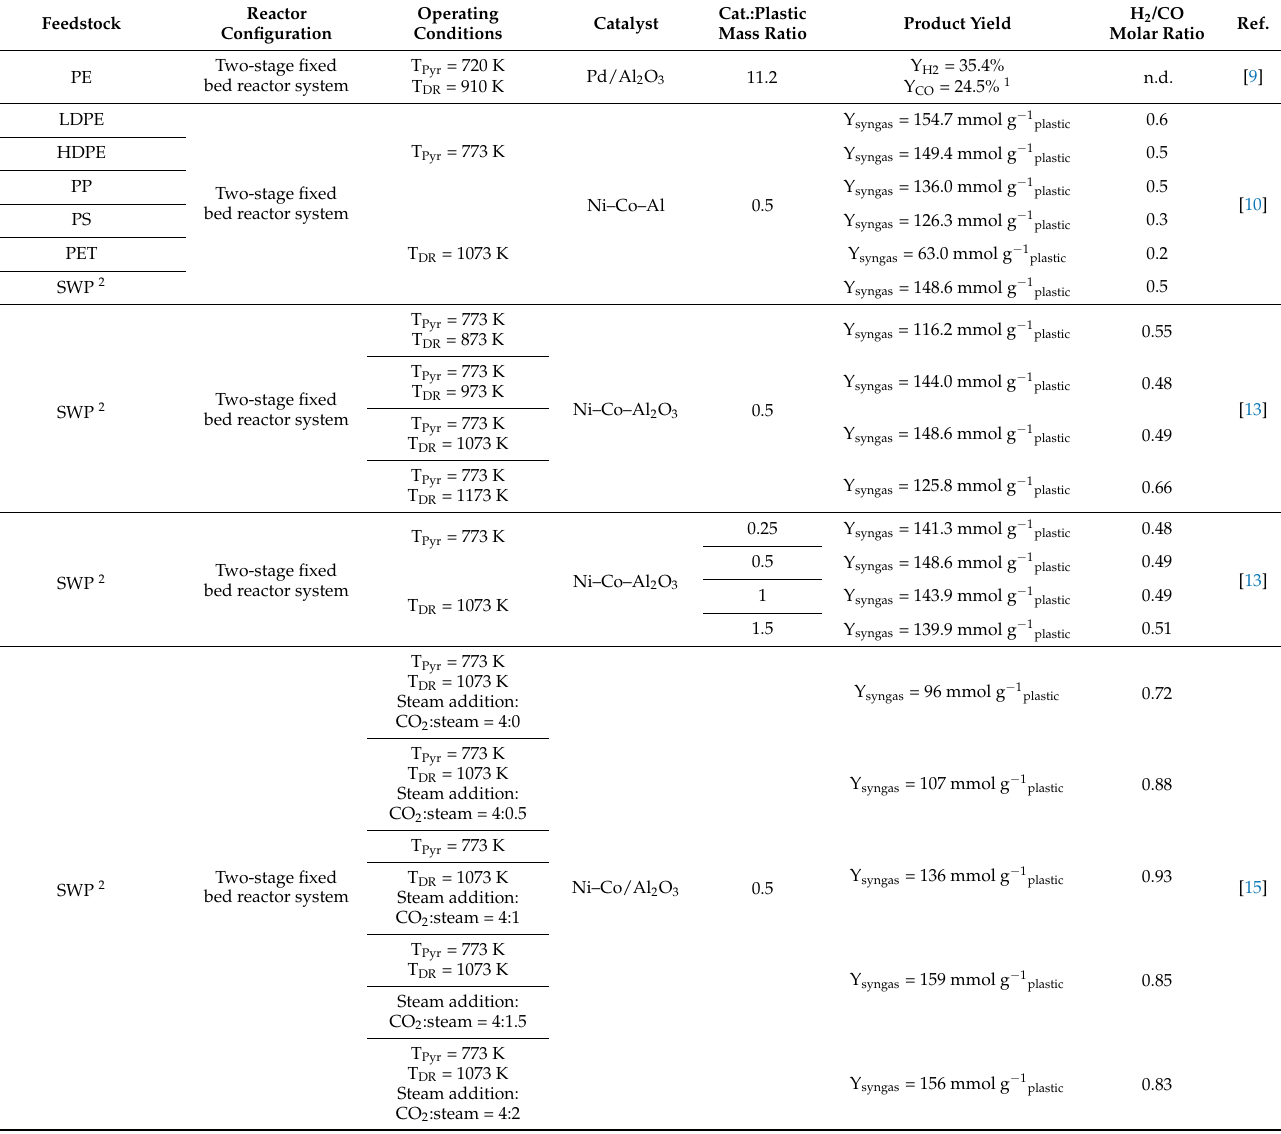
Table 3. PCDR processes reported in the literature with different process parameters and the yield and H 2 /CO ratio of obtained